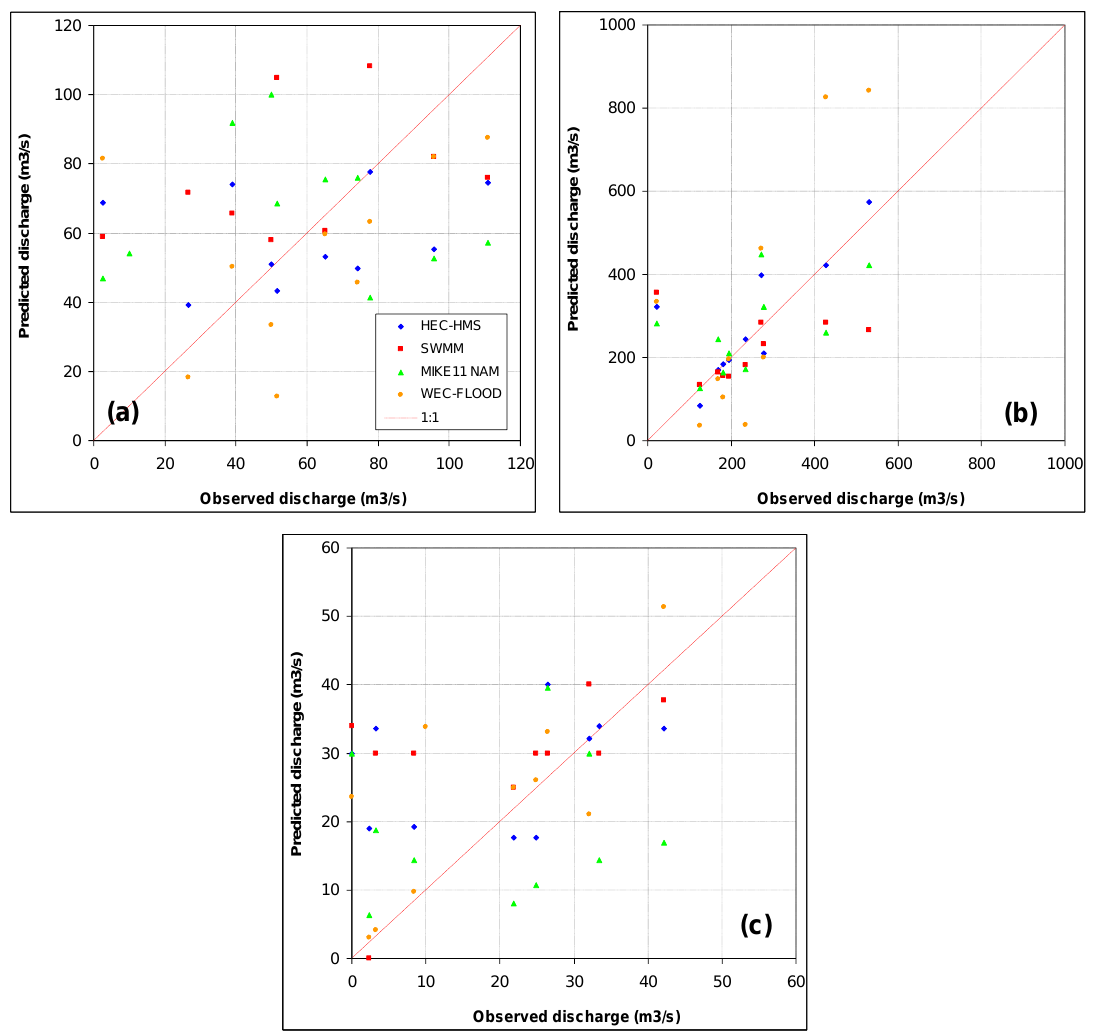
Figure 3. Scatter plots of mean ( a ), maximum ( b ) and minimum ( c ) water discharges observed and simulated using four hydrological models in the Mesima torrent (Calabria, Italy).